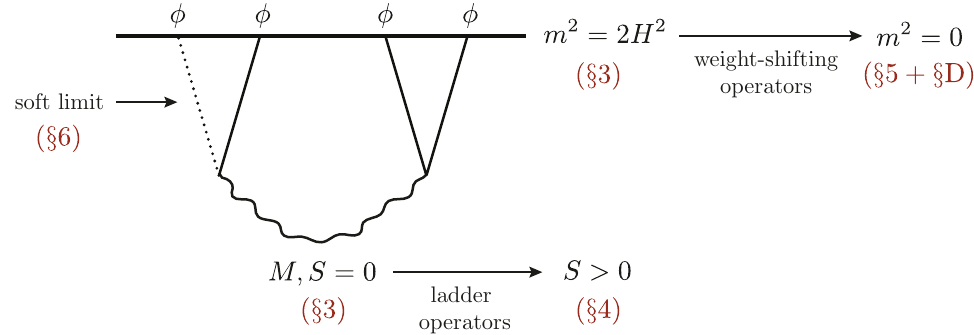
Figure 2. Schematic illustration of the logical connections between the di(cid:11)erent parts of the paper.